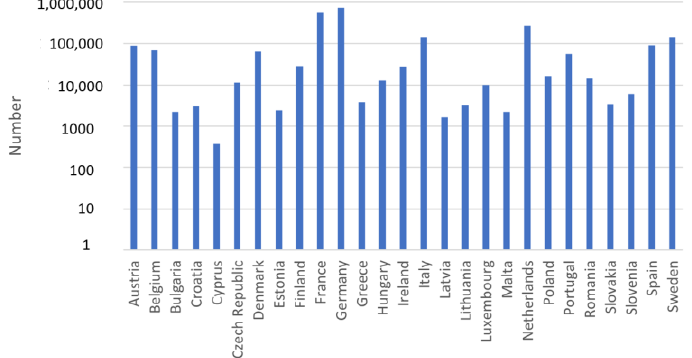
Figure 2. Dynamics of new registered electric vehicle passenger vehicles as a percentage of the total number of registrations at the European level (source [25]).